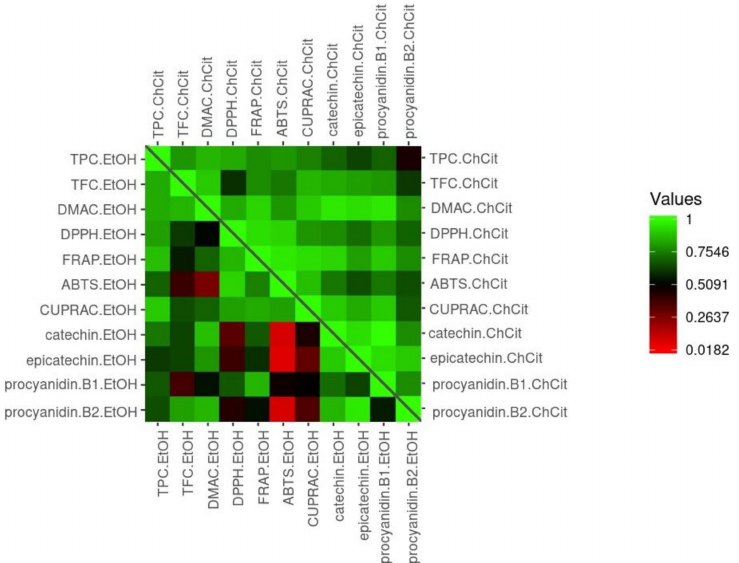
Figure 3. Heatmap of the correlations between antioxidant activity and phenolic compounds. Leg- end: ChCit—choline chloride:citric acid; EtOH—ethanol; TPC—total phenolic content; TFC—total flavonoid content; DMAC—4-dimethylaminocinnamaldehyde; DPPH—diphenylpicrylhydrazyl; FRAP—ferric ion reducing antioxidant power; ABTS—2,2 (cid:48) -azino-bis-3-ethylbenzothiazoline-6- sulfonic acid; CUPRAC—cupric ion reducing antioxidant